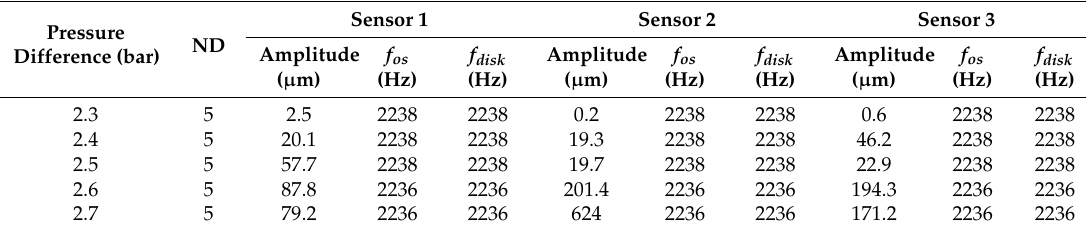
Table 2. Results for the first prototype at 0 rpm.